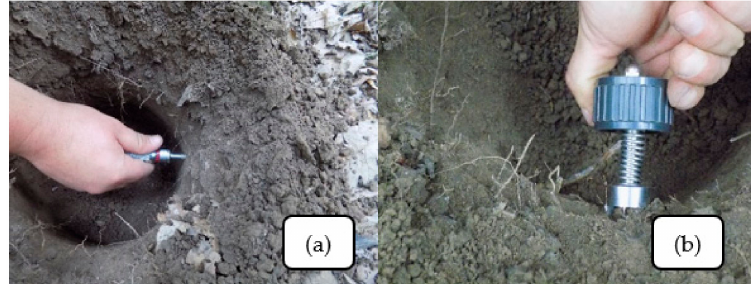
Figure 3. Example of measurements of resistance to penetration ( a ) and shear strength ( b